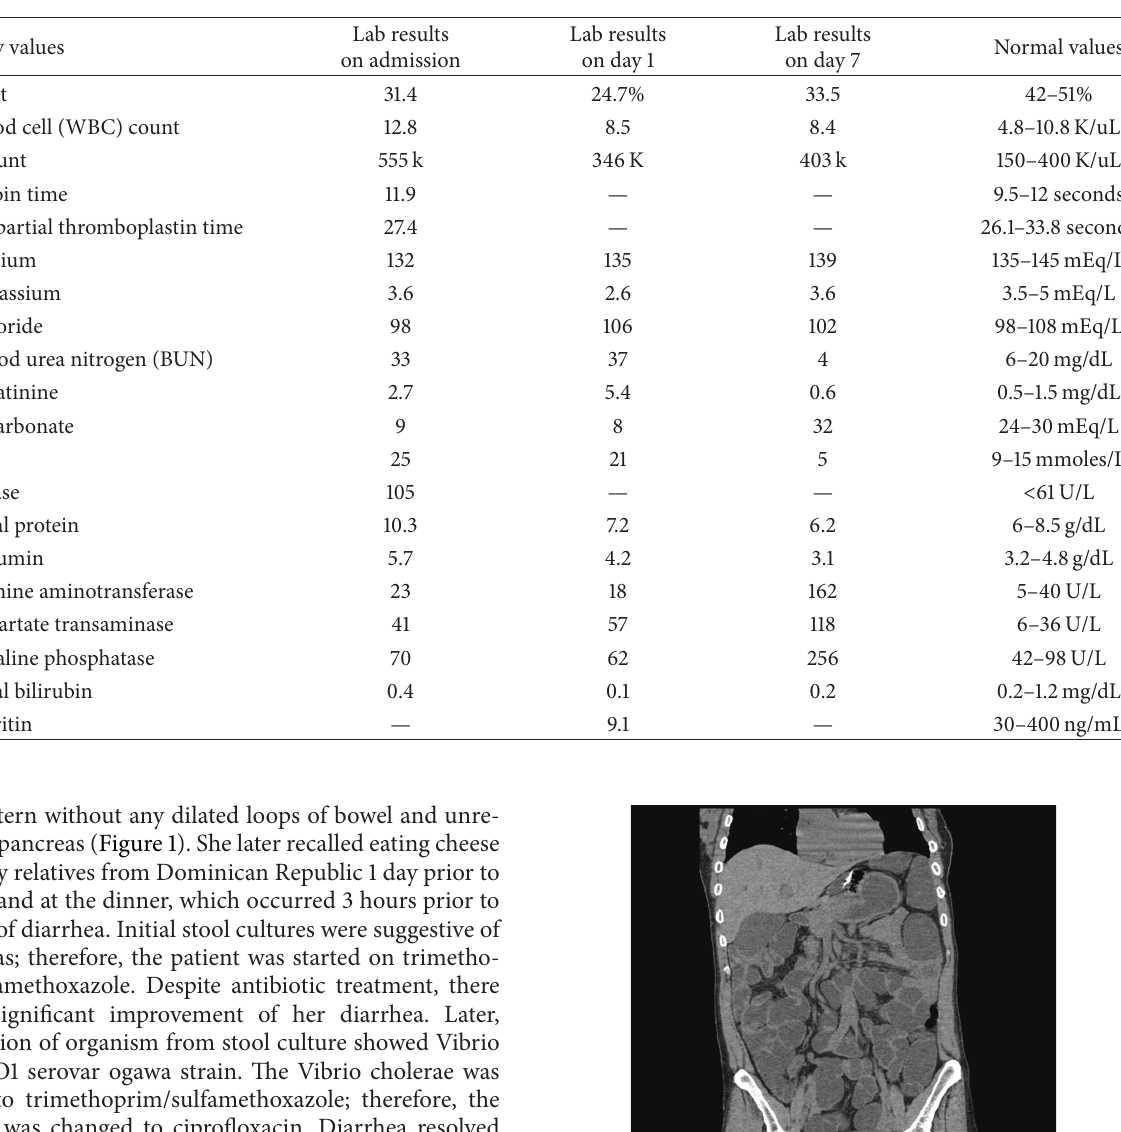
Table 1: Laboratory test results.